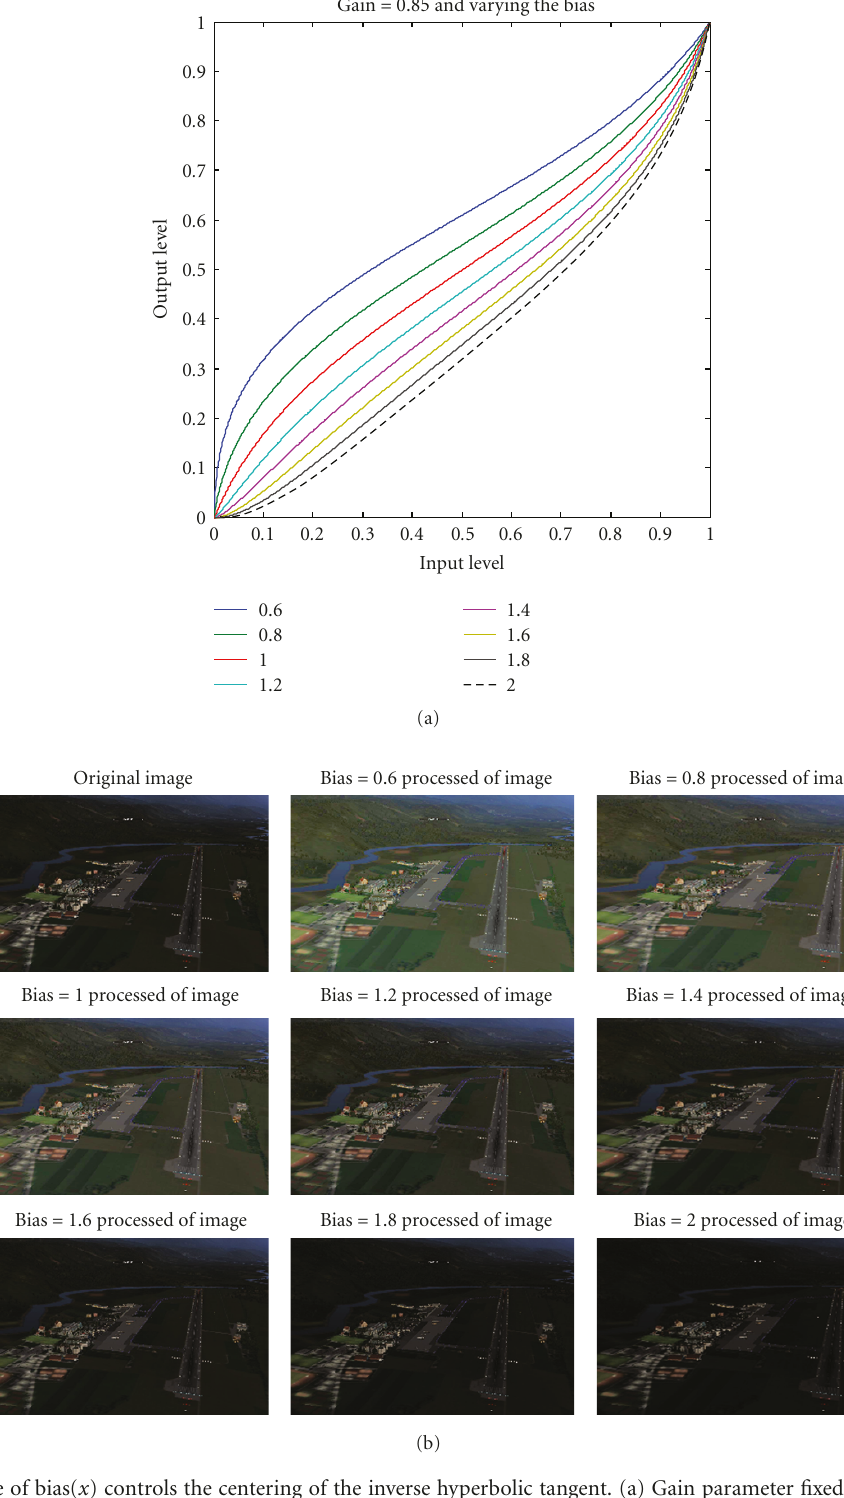
Figure 15: The value of bias( x ) controls the centering of the inverse hyperbolic tangent. (a) Gain parameter fixed (gain = 0.85) and nine di ff erent bias values of mapping curves, (b) fixed gain = 0.85, processed of